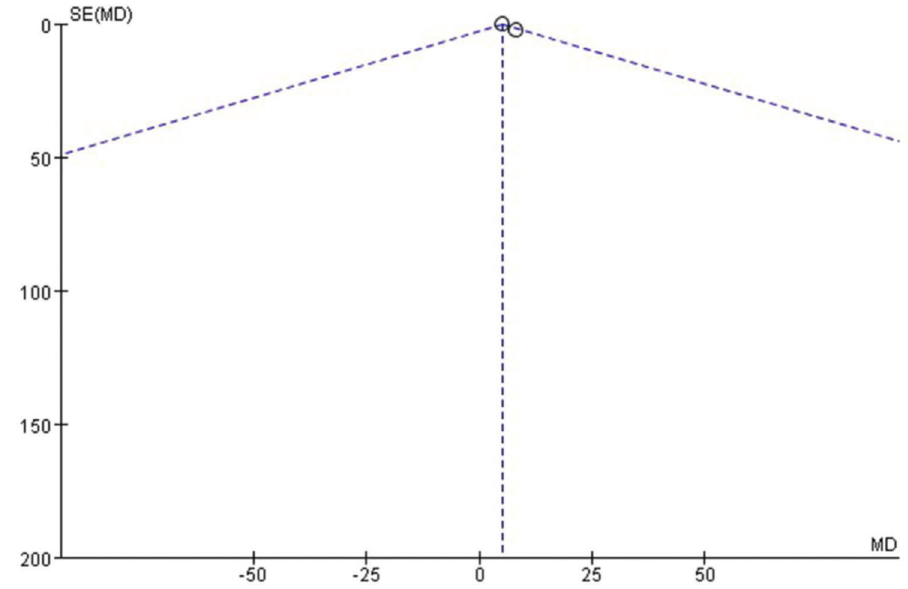
Figure 4 - Funnel chart of the relationship between interleukin-6 and the severity of acute coronary syndrome. SE, standard error; MD, mean difference.